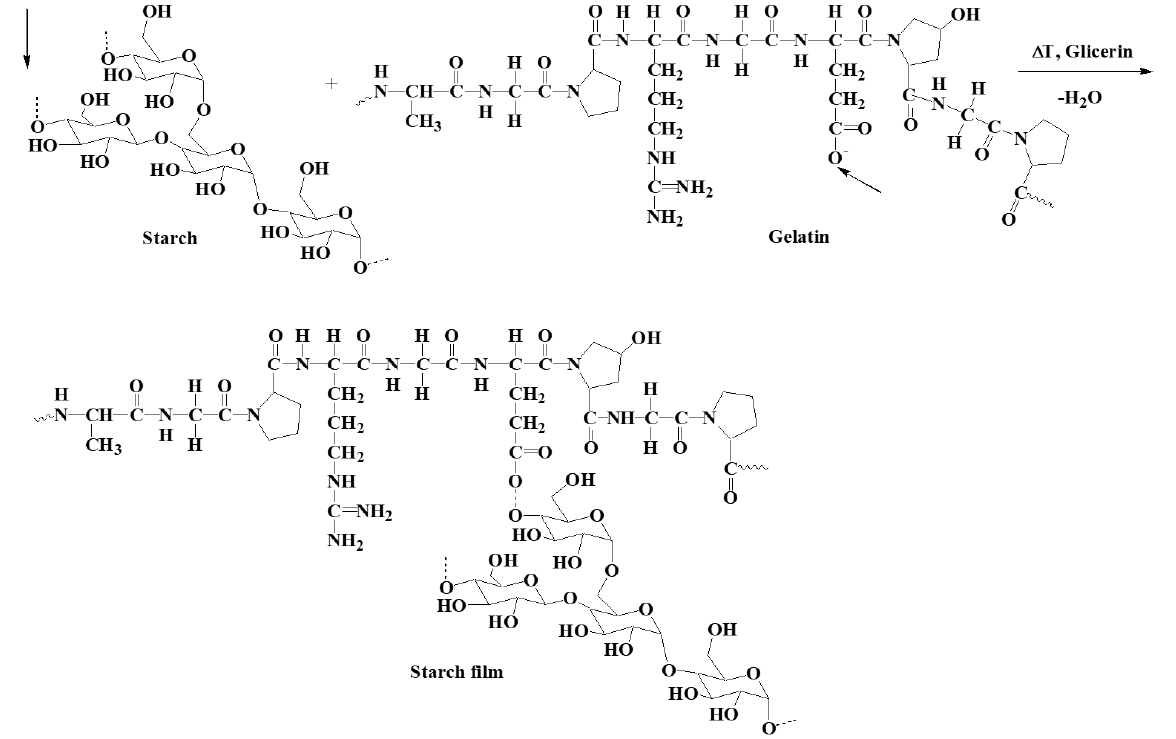
Figure 9. Probable interactions between starch and gelatin macromolecules [30].